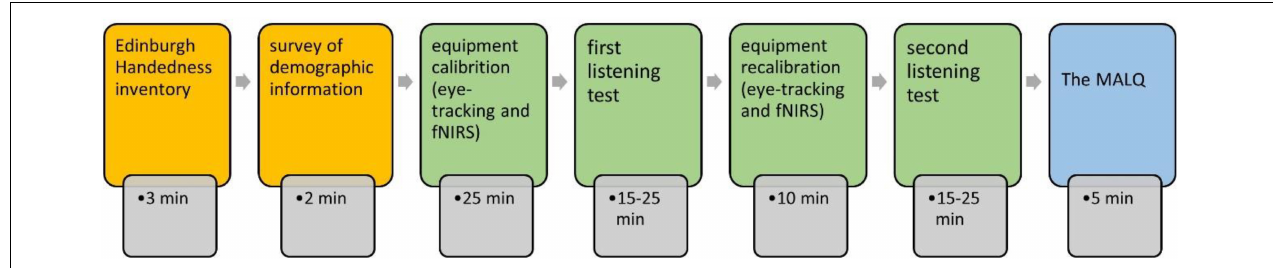
FIGURE 1 | Research design. fNIRS, functional near-infrared spectroscopy; MALQ, metacognitive awareness listening questionnaire.